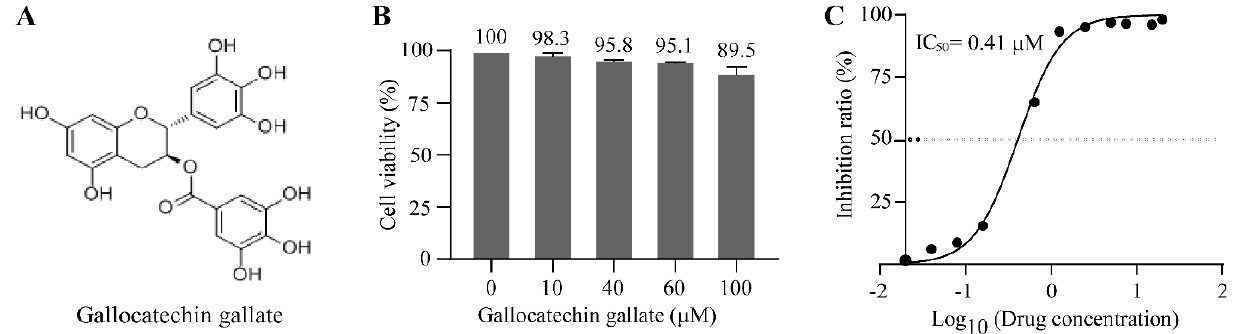
Figure 2. The cell cytotoxicity of gallocatechin gallate and its IC 50 to the replication of PRV in PK15 cells. ( A ) The chemical formula of gallocatechin gallate. ( B ) PK15 cells in 96-well plates were treated with gallocatechin gallate at concentrations of 10 μ M, 40 μ M, 60 μ M, and 100 μ M for 24 h, and then CCK-8 (10 μ L) solution was added and incubated for 3 h. The absorbance value at 450 nm was measured, and the results were calculated as the percentage of the OD 450 of gallocatechin gallate-treated group to the DMSO-treated group. ( C ) The IC 50 of gallocatechin gallate was 0.41 μ M. PK15 cells in 96-well plates were pretreated with gallocatechin gallate at concentrations of 0.02 μ M, 0.04 μ M, 0.08 μ M, 0.16 μ M, 0.64 μ M, 1.25 μ M, 2.5 μ M, 5 μ M, 7.5 μ M, 15 μ M, and 20 μ M. Two hours later,